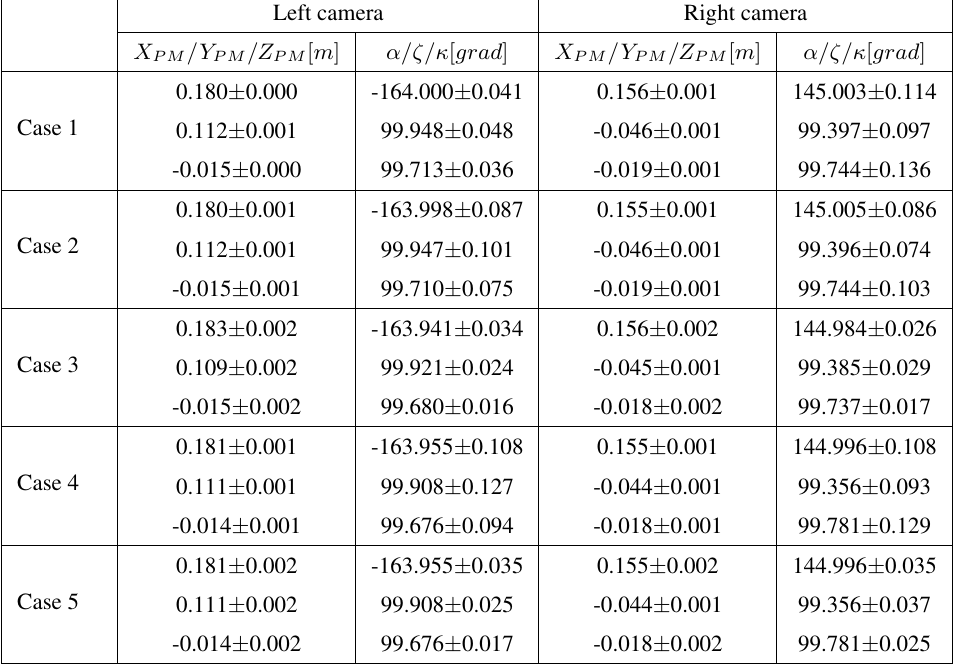
Table 3. Computed mounting calibration parameters and related